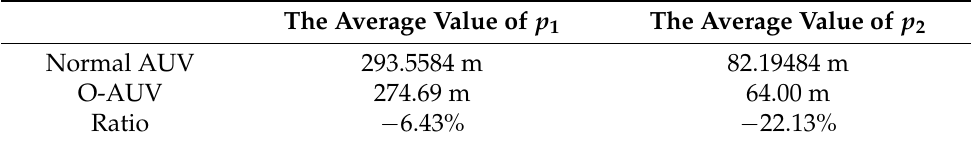
Table 4. Comparison between different type of AUVs.